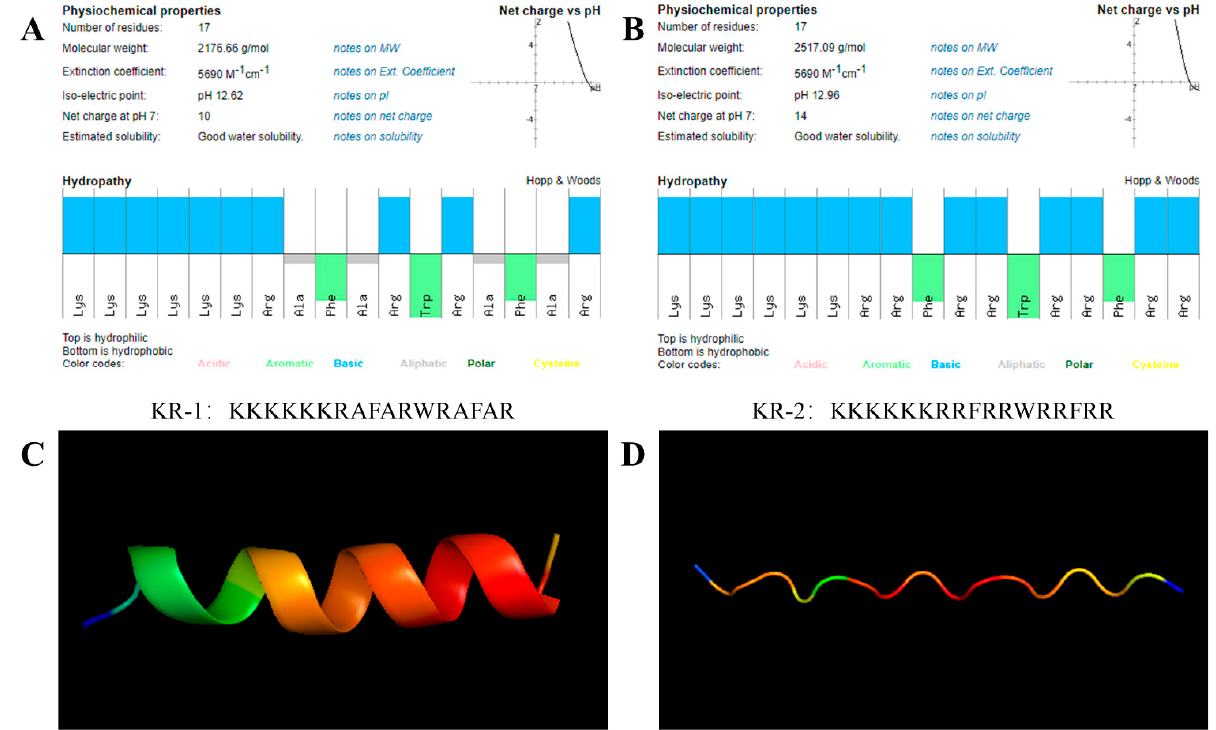
Figure 1. Basic properties of antibacterial peptides. ( A , B ) Molecular characteristics and physicochemical properties of amphiphilic antimicrobial peptides KR − 1 and KR − 2 (top: hydrophilic; bottom: hydrophobic). ( C , D ) Alphafold predicted the tertiary structures of KR − 1 and KR − 2.